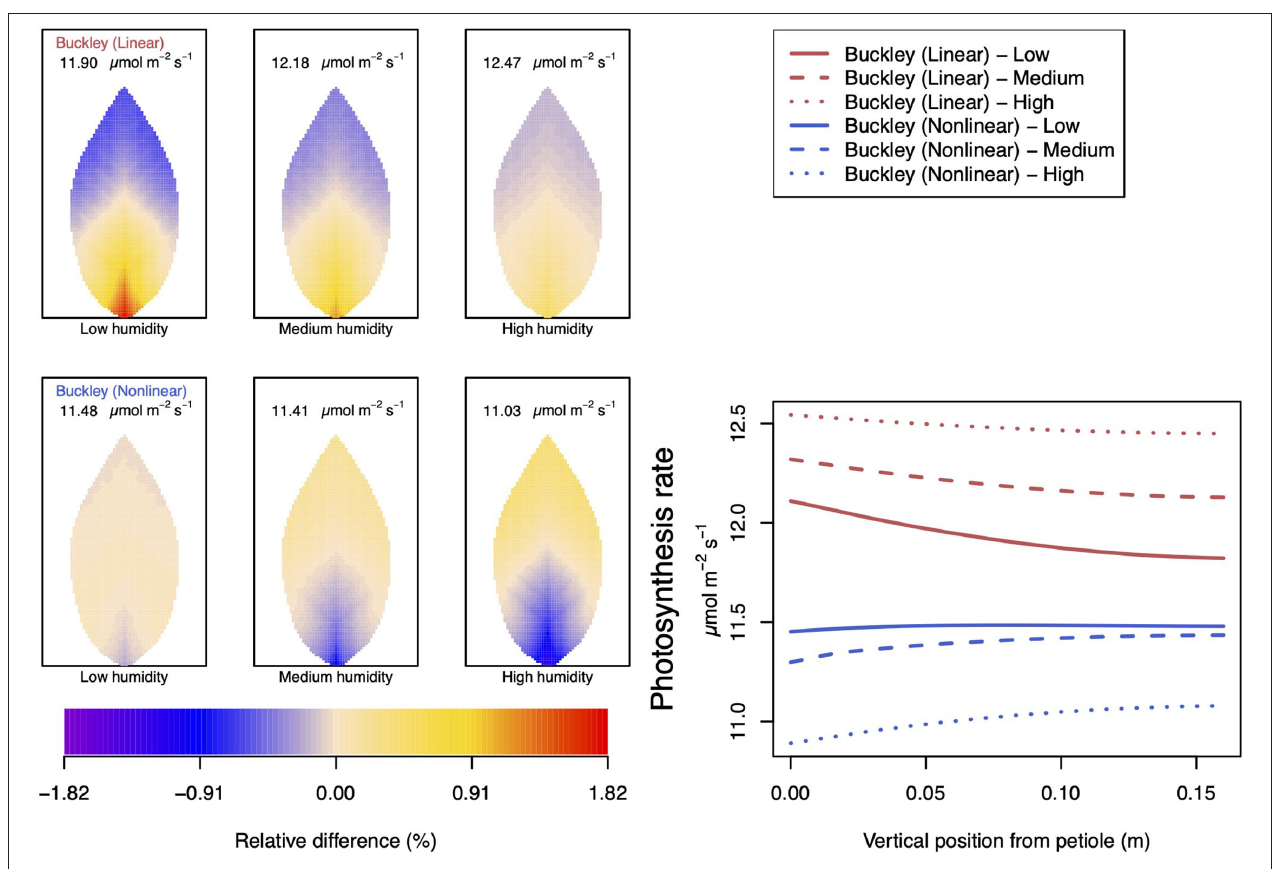
FIGURE 11 | A comparison of model predictions of photosynthetic activity distributed over the leaf for different values of relative humidity . Details as in Figure 7 , except for a temperature of 10 ◦ C (283.15 K) . In this case, the uniform/leaf-area average predictions using the Leuning (1995) stomatal model are 12.47, 13.29, and 14.23 µ mol m − 2 s − 1 under low, medium, and high humidity, respectively (2D heat maps are not